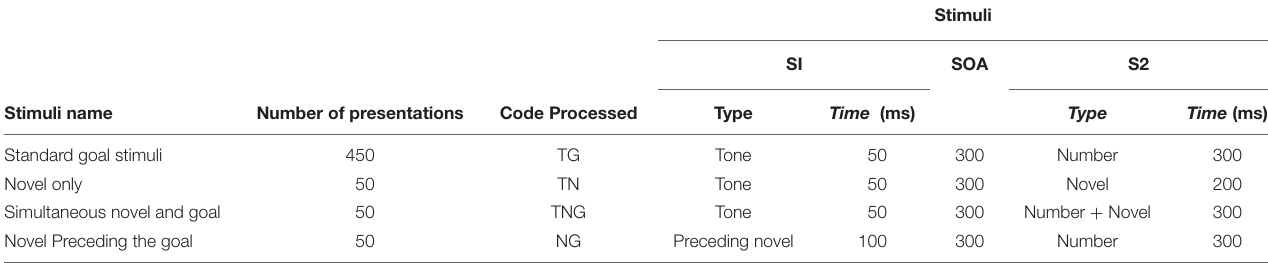
TABLE 1 | Stimuli combinations for the experiment